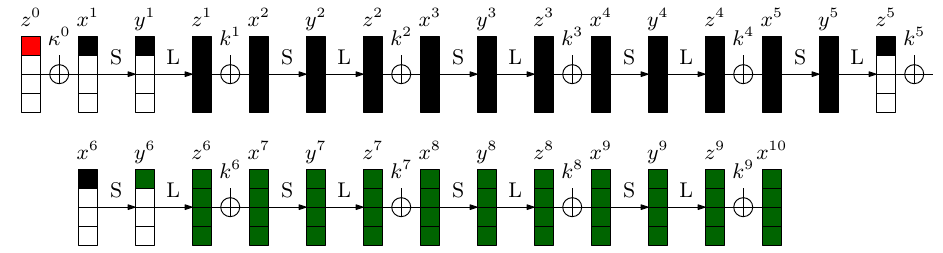
Figure 7: Generalized Demirci-Selçuk attack on 9 round version of